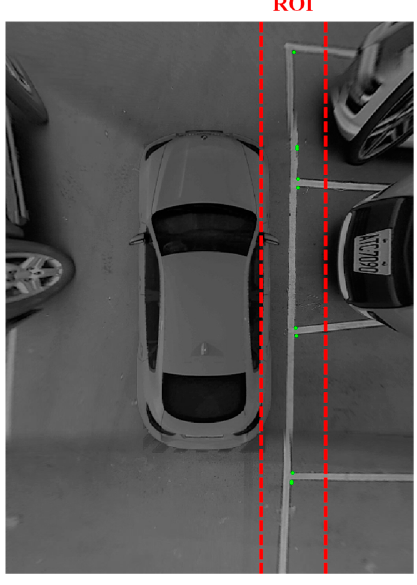
Figure 8. Results of feature classification.